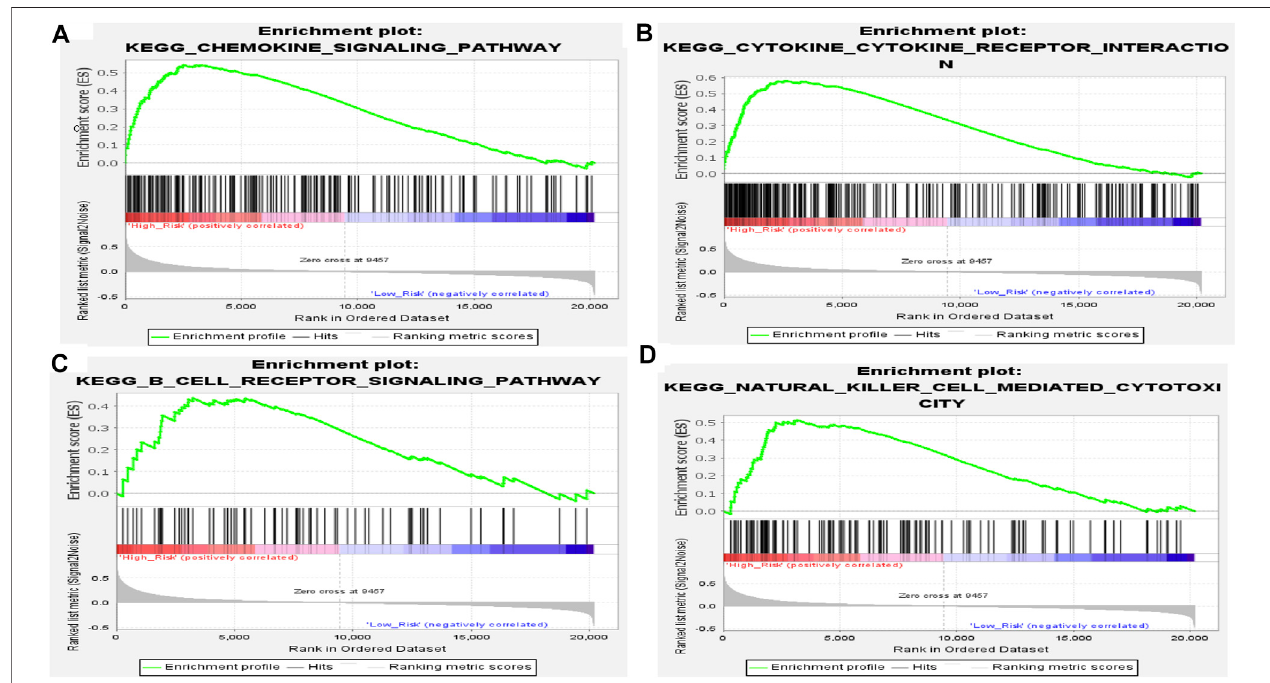
FIGURE 7 | Results of GSEA of KEGG pathway in high- and low-risk groups in the training set. (A) Chemokine signaling pathway. (B) Cytokine – cytokine receptor interaction. (C) B-cell receptor signaling pathway. (D) Natural killer cell-mediated cytotoxicity.